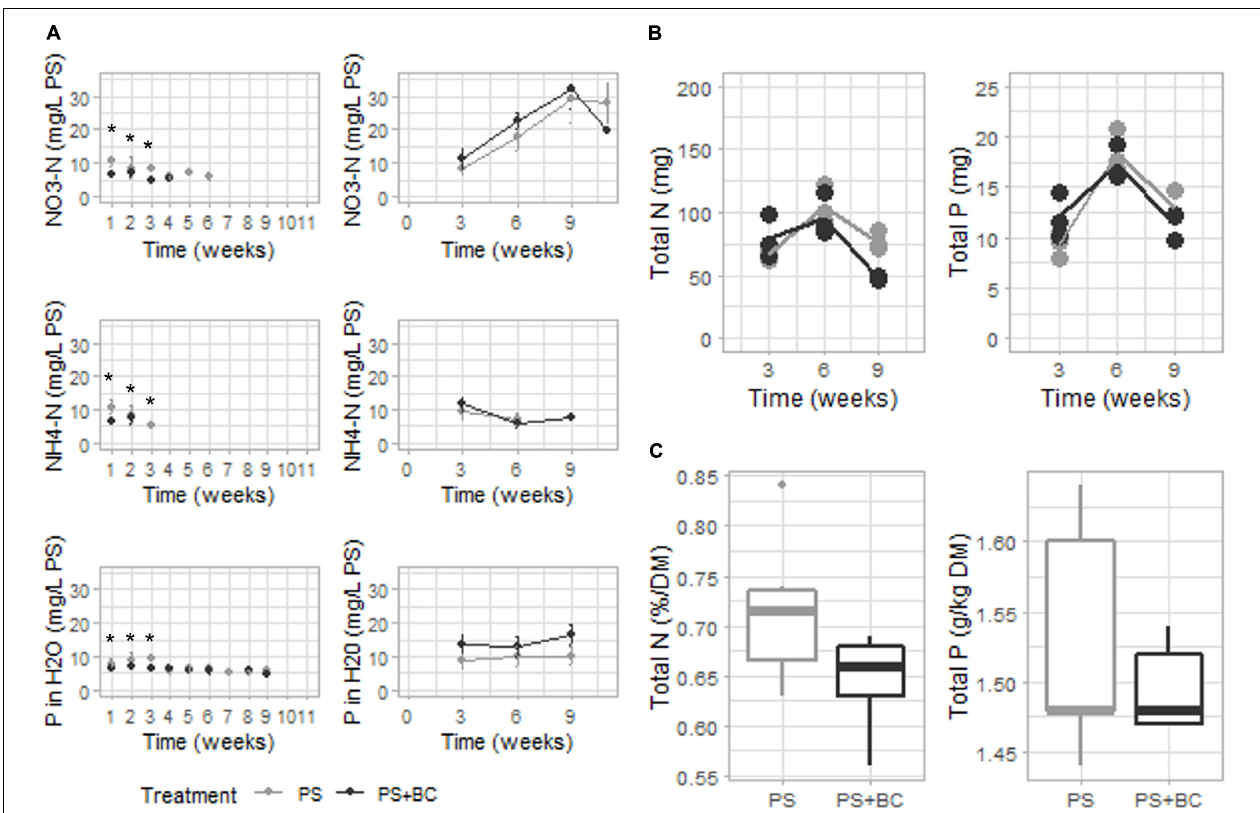
FIGURE 3 | Chemical characterization of the PS with plants, strawberry fresh leaves, and strawberry fruits over 11 weeks of plant growth. (A) Plant-available nitrogen (N) (NO 3 -N and NH 4 -N), phosphorous (P) concentrations of either of the PS mixtures [without or with 2 g of biochar per liter added (PS + CH)] in which plants were grown (left), and NO 3 -N, NH 4 -N, and SO 4 concentrations of either PS mixtures in which no plants were grown (right). Dots represent the mean value with the SD as error bars ( n = 3). If no values occur, the measurement was below the detection limit. (B) Total N and P contents (in mg/pot) measured in plant leaves per plant on weeks 3, 6, and 9 of the experiment. Mean values are represented as lines, and dots represent the values of the biological replicates ( n = 3). (C) Concentrations of N (percentage on DM) and P (in g/kg DM) of strawberry fruits are represented ( n = 5). Replicates are considered as all fruits picked from all plants grown in either PS or PS + BC at one specific time point (at 5, 6, 7, 8, and 9 weeks of plant growth). Statistical significances are indicated with an asterisk (* p <